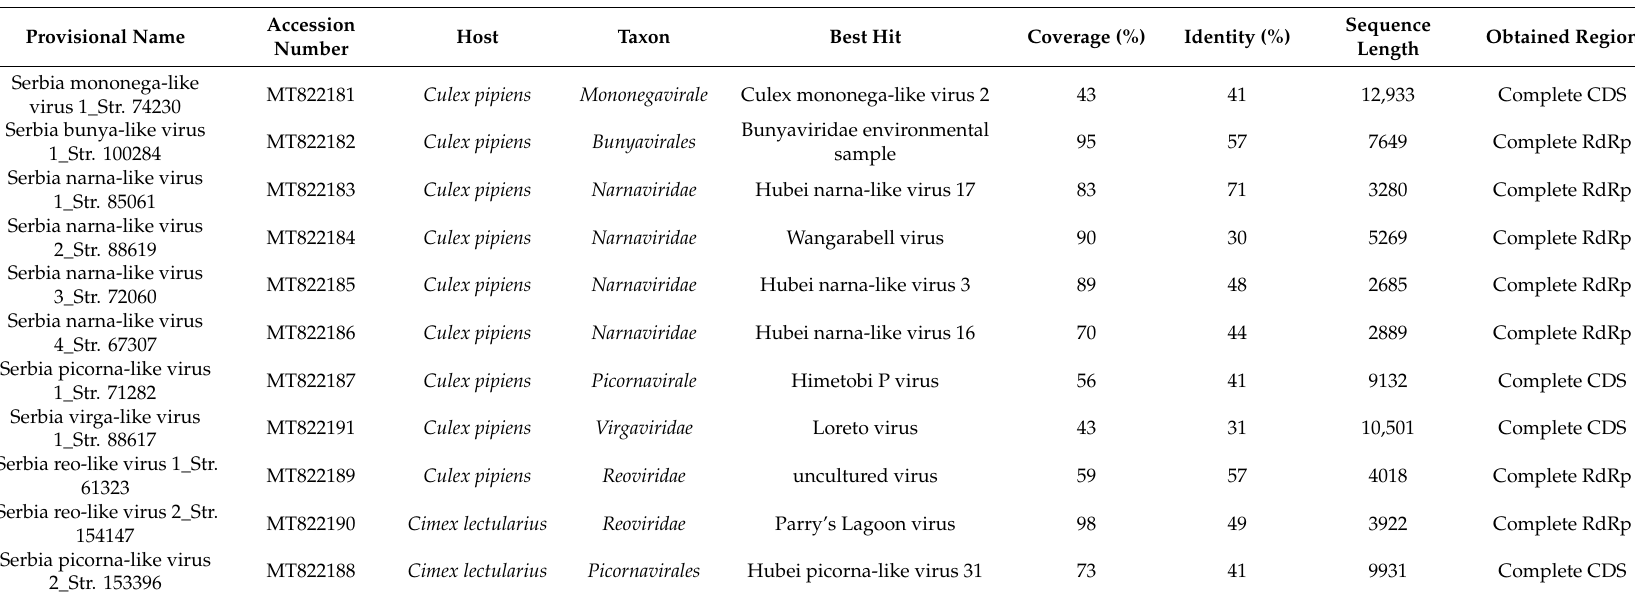
Table 2. Novel viruses identified in this